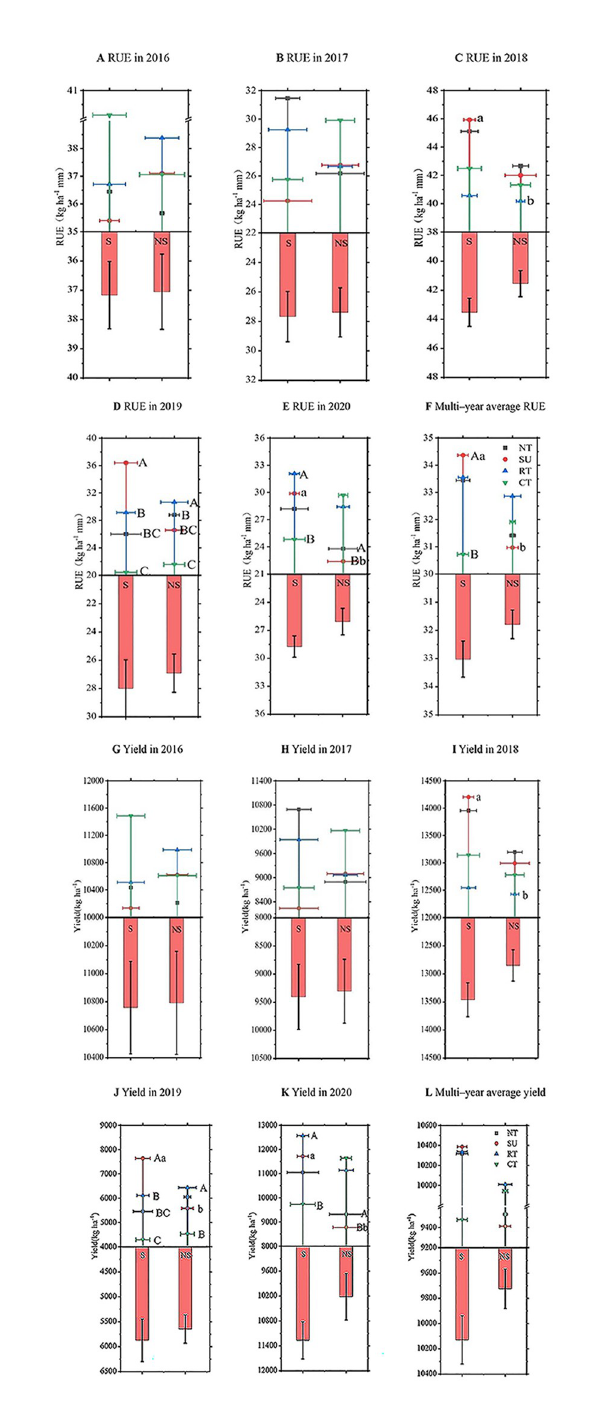
Fig 8. Diagram of RUE and yield affected by tillage cultivation. Note: S, straw return; NS, straw removal. Different capital letters on the error bars indicate significant differences among different tillage cultivations under the same straw treatments ( P < 0.05, double tailed test), and different lowercase letters indicate the same tillage cultivation with significant differences under different straw treatments ( P < 0.05, double tailed test). No letters on the error bars indicates no significant differences ( P > 0.05, double tailed